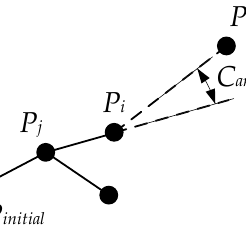
Figure 6. Different driving states.